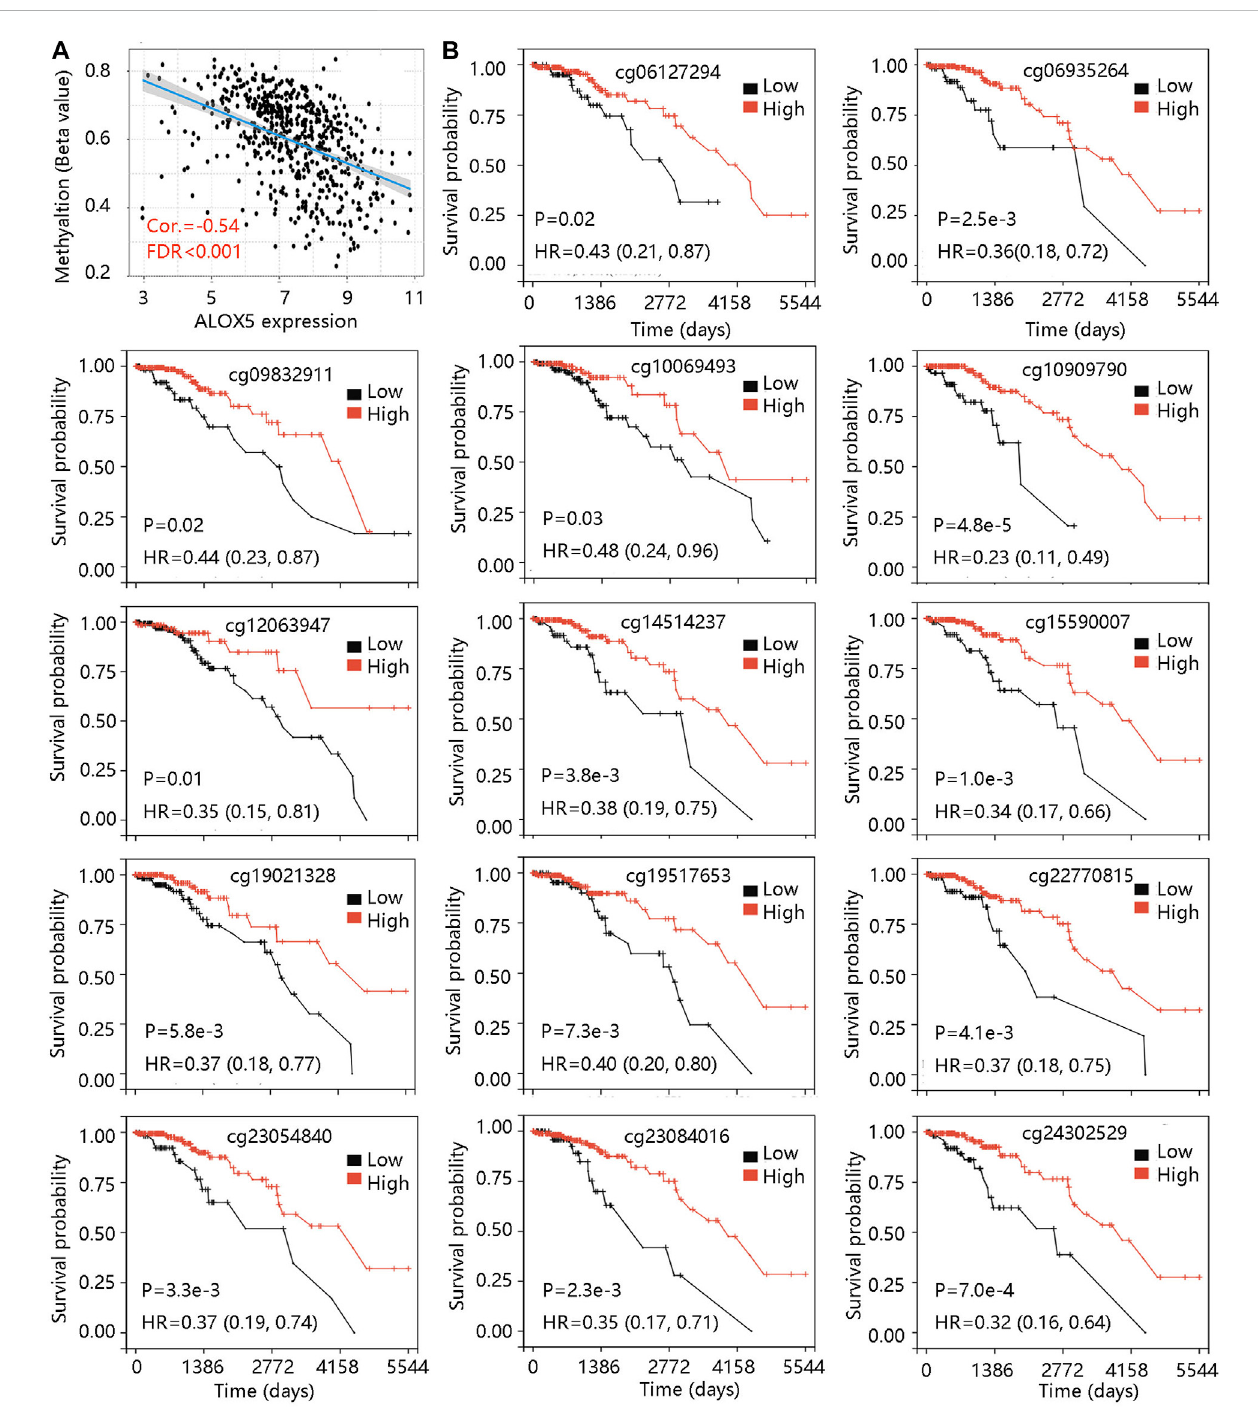
FIGURE 7 The ALOX5 methylation analysis in TCGA-LGG cohort. (A) The negative correlation between ALOX5 mRNA expression and its methylation level. (B) The prognostic value of the 14 methylated sites of ALOX5. FDR, false discover rate; HR, hazard ratio.